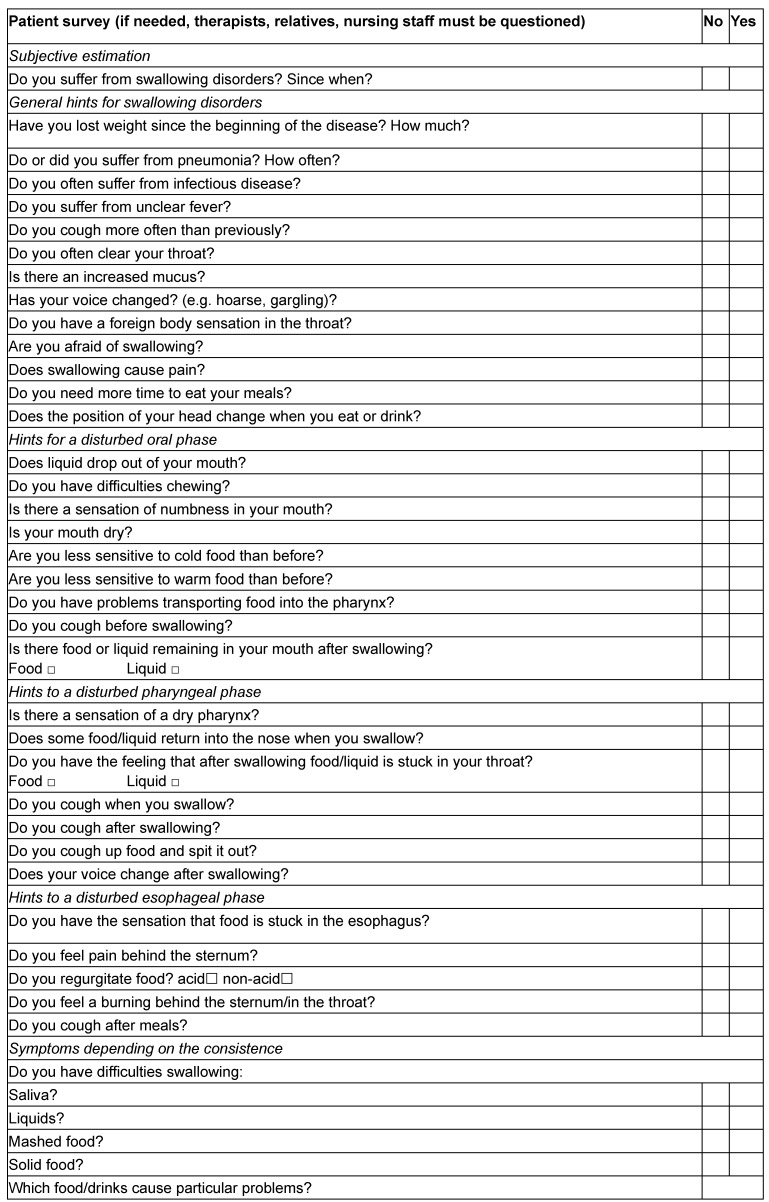
Questionnaire for anamnesis of swallowing disorders